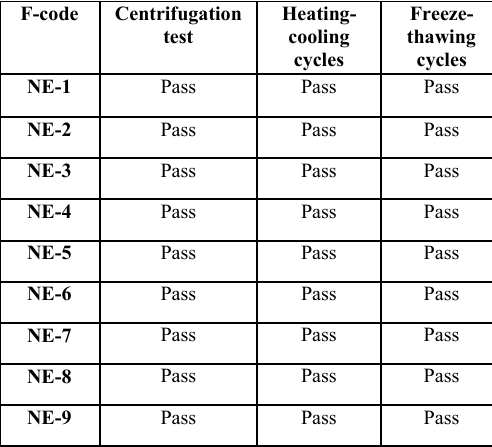
Table 3. Results of thermodynamic stability studies For LCDP nanoemulsions .